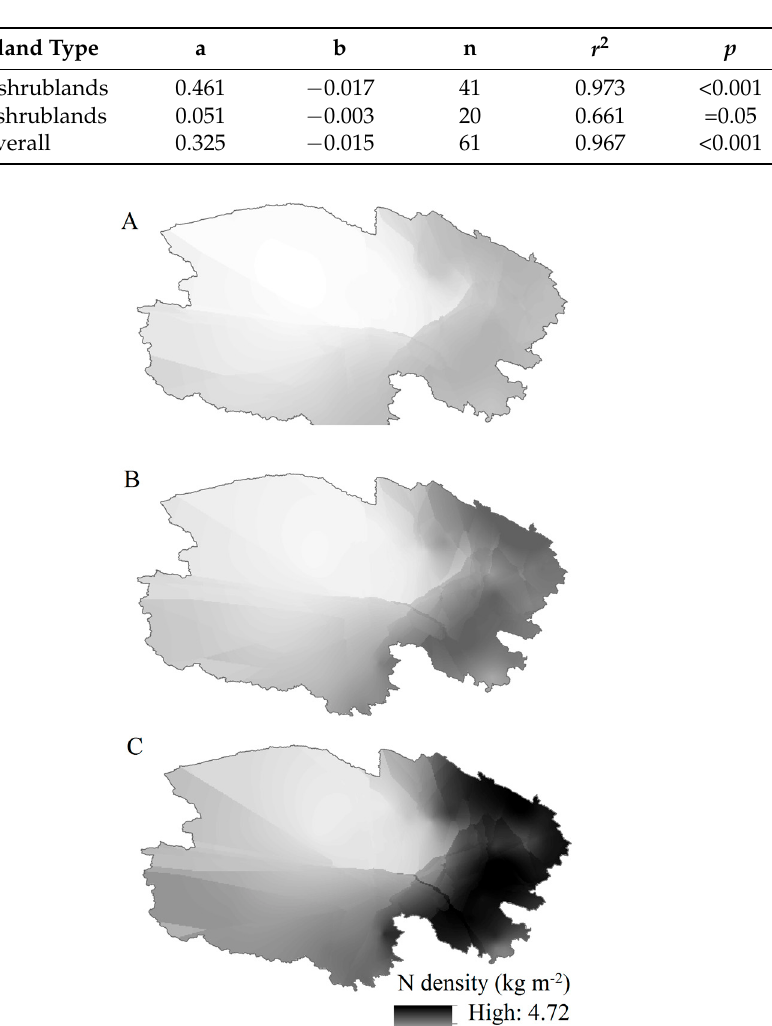
Table 2. Parameters a and b in the exponential equation for different shrublands types, which was described as ND ( i ) = a × e b × i .